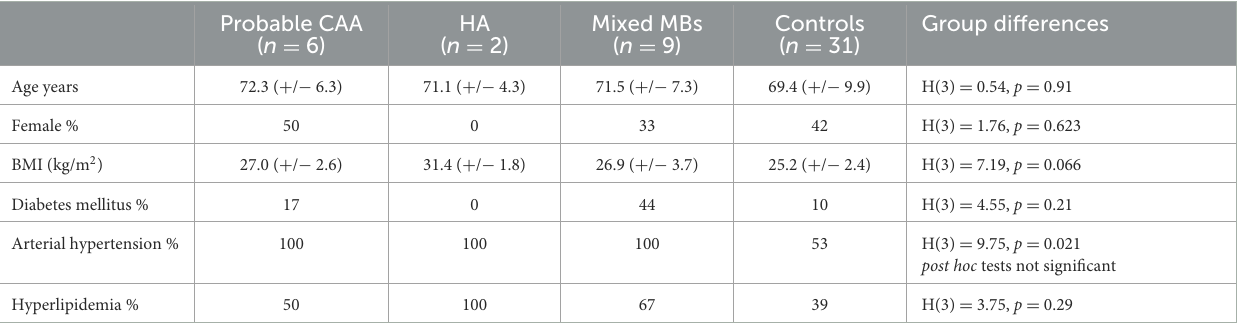
(Figure 5). They represented 3.6% (11/301) of the lobar MBs, 3% (2/66) of the deep and 27.9% (12/43) of the infratentorial MBs found on 7T T2 ∗ -w imaging. Calcifications were found in 29.8% (14/48) of all study participants, more specifically in 50% (3/6) of the probable CAA, 67% (6/9) of the mixed CSVD patients and 100% (2/2) of the HA patients, whereas this was the